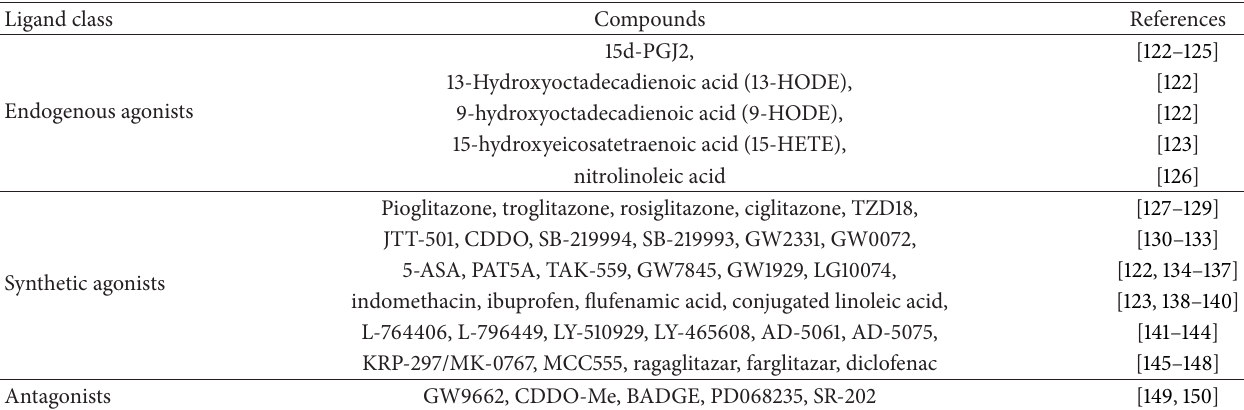
Table 1: Ligands for PPAR 𝛾